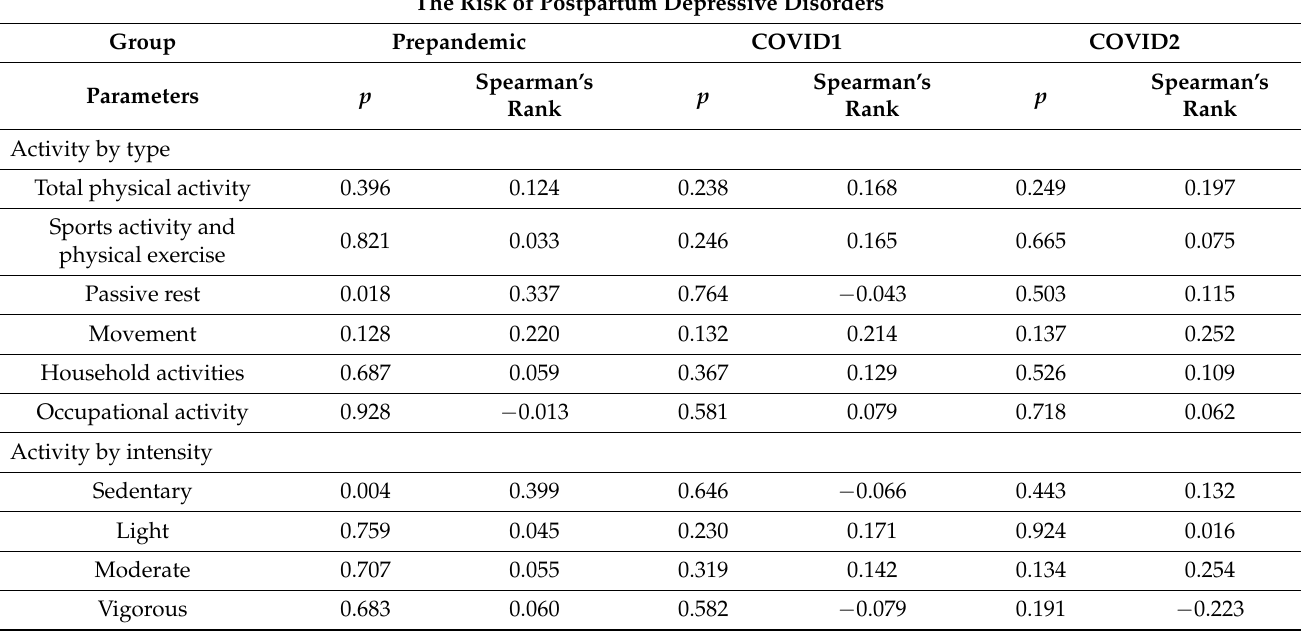
Table 3. Spearman’s Rank Correlations between depressive disorders and physical activity—type and intensity of